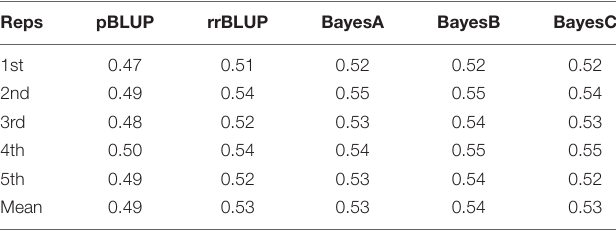
TABLE 1 | Mean survival accuracy for D1 1 (5-fold cross validation; 5